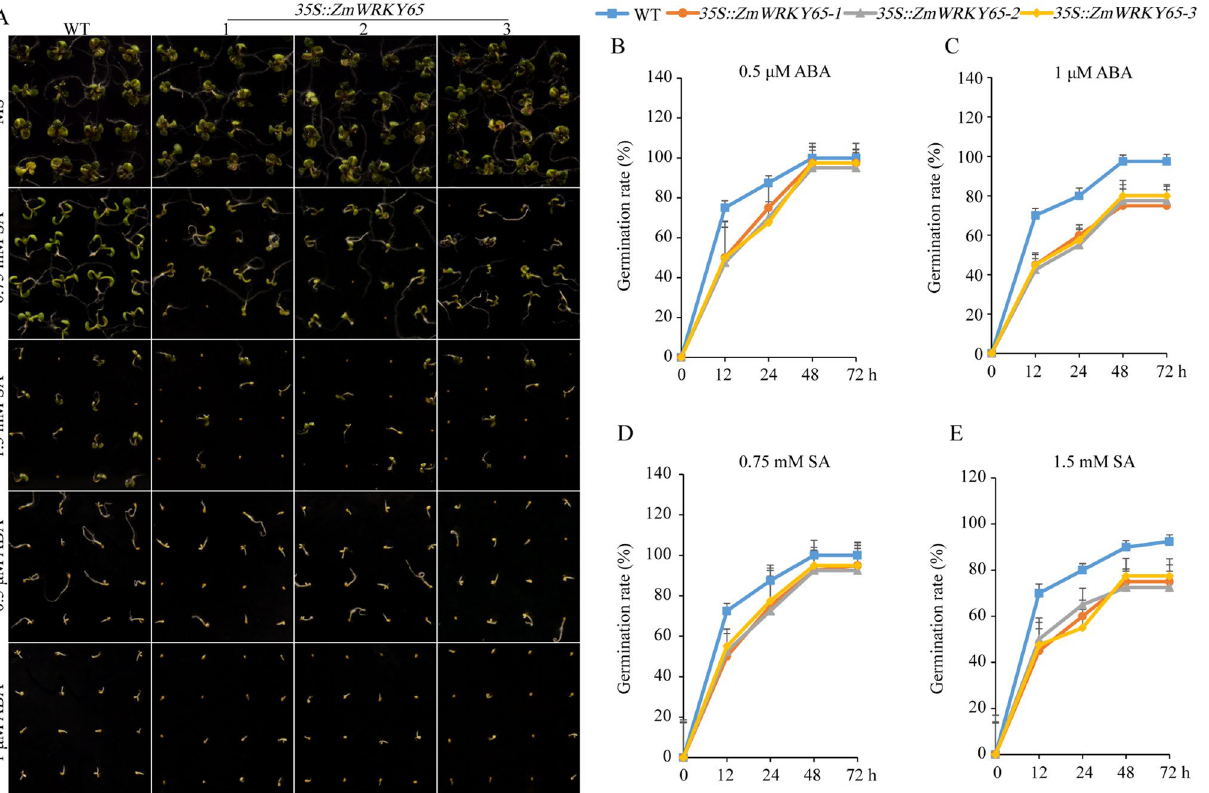
Figure 4. Germination of transgenic Arabidopsis plants and WT under different hormone treatments. ( A ) The germination phenotypes of WT and ZmWRKY65 transgenic Arabidopsis plants under different hormone treatments. ( B ) The germination rates of WT and ZmWRKY65 transgenic Arabidopsis plants under 0.5 μM ABA treatment. ( C ) The germination rates of WT and ZmWRKY65 transgenic Arabidopsis plants under 1 μM ABA treatment. ( D ) The germination rates of WT and transgenic ZmWRKY65 Arabidopsis plants under 0.75 mM SA treatment. ( E ) The germination rates of WT and ZmWRKY65 transgenic Arabidopsis plants under 1.5 mM SA treatment. The results are averages of three replicates. Vertical bars indicate ± SE of three